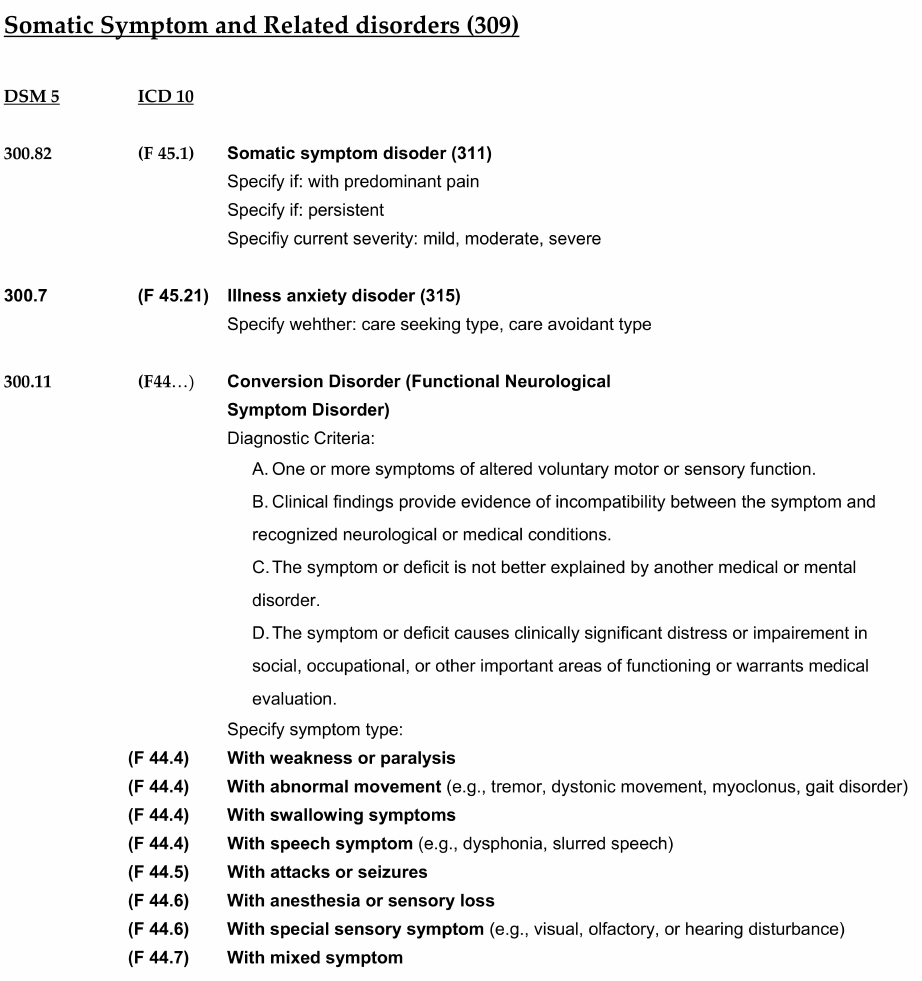
Figure 1. Diagnostic and Statistical Manual of Mental Disorders DSM-5/ICD 10.